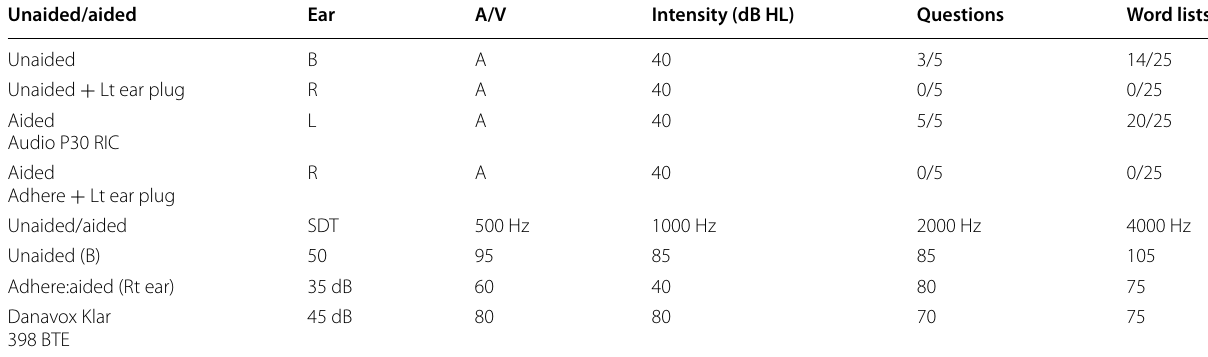
Table 1 Hearing aid trail and outcomes on testing digital hearing aids in aided and unaided conditions Unaided/aided Ear A/V Intensity (dB HL) Questions Word